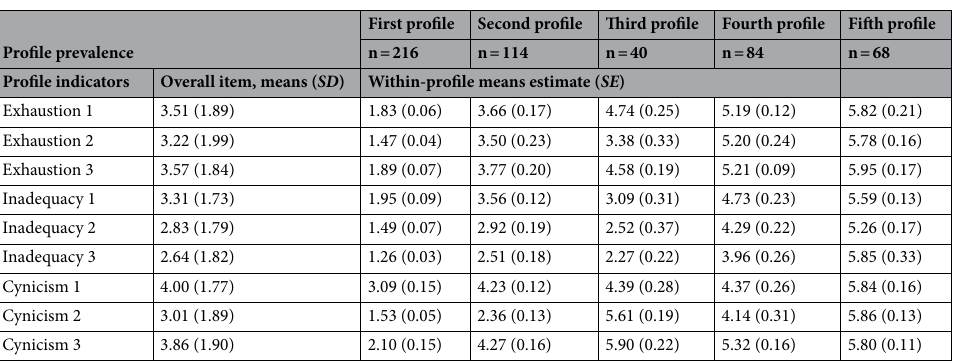
Table 3. Parameter estimates for the five-profile model of teacher burnout risk. First profile: “No burnout risk”; Second profile: “Low burnout risk”; Third profile: “Cynics”; Fourth profile: “Exhausted and cynics”; Fifth profile: “High burnout